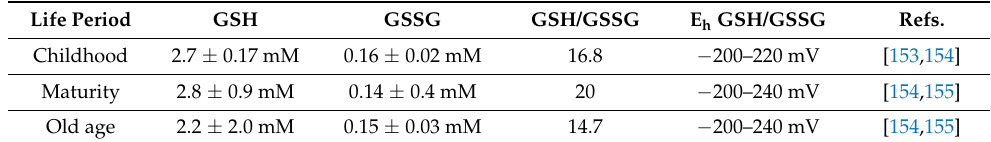
Table 3. GSH, GSSG concentrations, GSH:GSSG ratio and EhGSH/GSSG at different stages of an individual’s